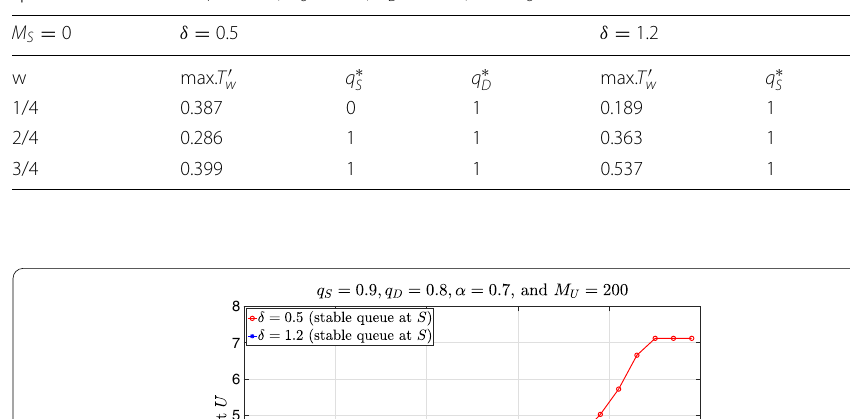
and q ∗ for which the weighted sum throughput is maximized when the S D